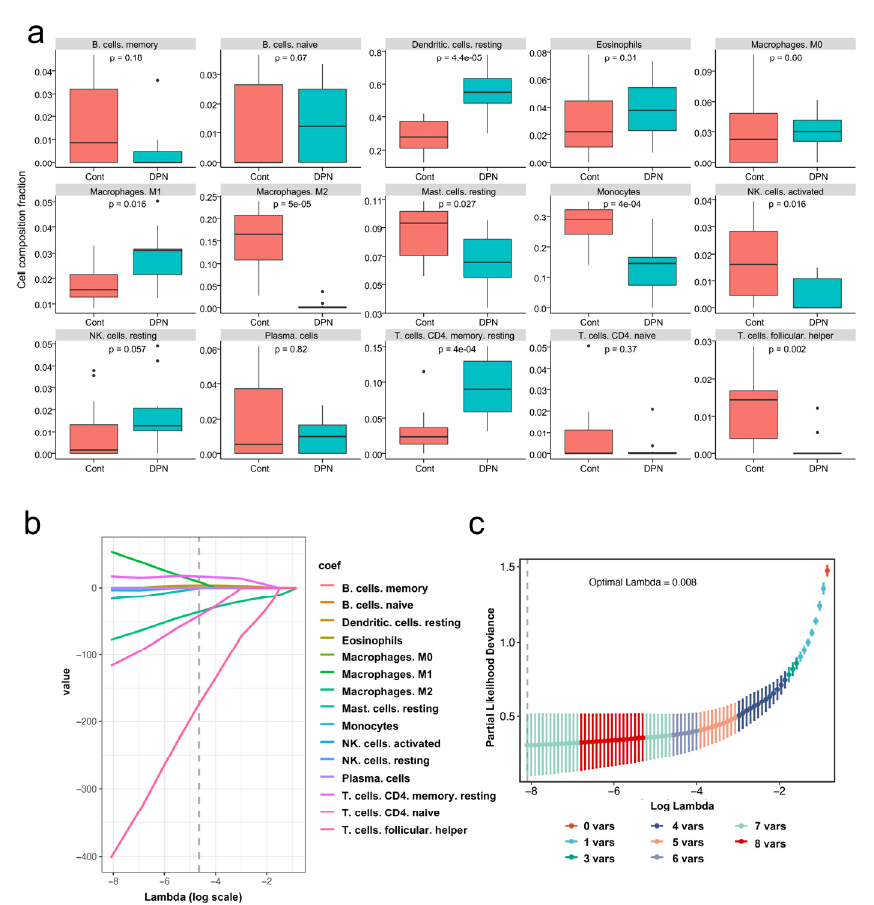
Figure 6. Identifying the infiltration levels of immune cell populations in DPN. ( a ) Box plots showing the infiltrating immune cells in DPN samples compared to normal samples. ( b , c ) The least absolute shrinkage and selection operator (LASSO) logistic regression algorithm was conducted to analyze the different infiltrates of immune cells in DPN and control samples. Different colors represent different types of immune cells. Trajectories of the independent variables of LASSO regression, the horizontal coordinates indicate the logarithm of the independent variable Lambda, and the vertical coordinates indicate the coefficients of the independent variables. LASSO regression under each Lambda confidence interval.